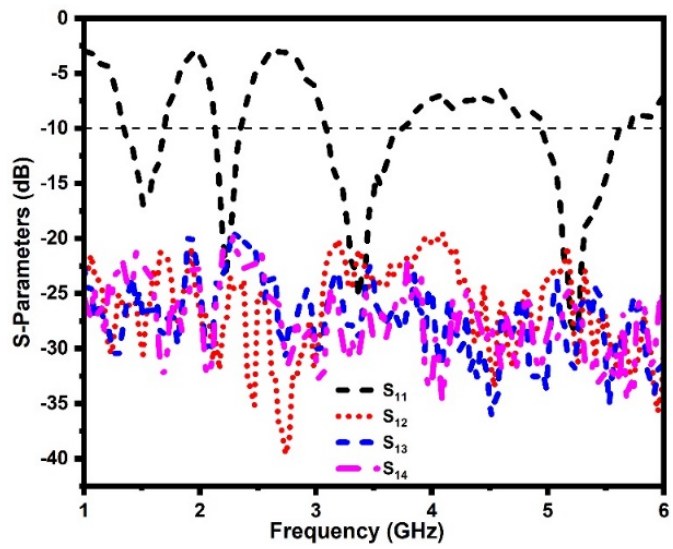
Figure 9. Measured S − parameters of the proposed antenna.